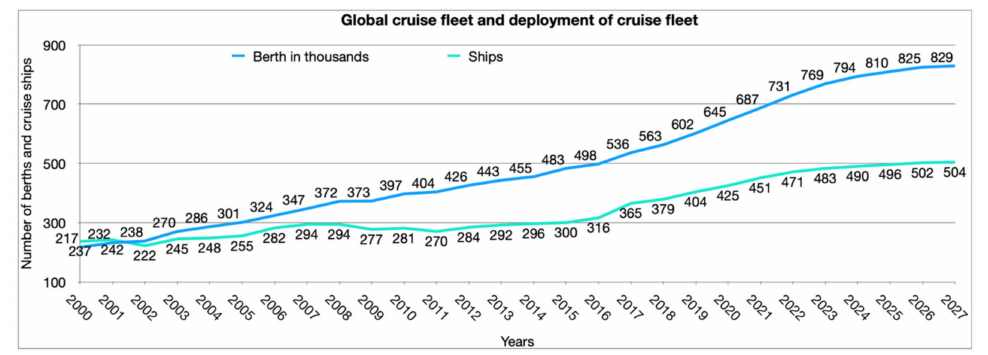
Figure 1. Global cruise fleet and deployment of cruise fleet. Adopted from Cruise Industry News